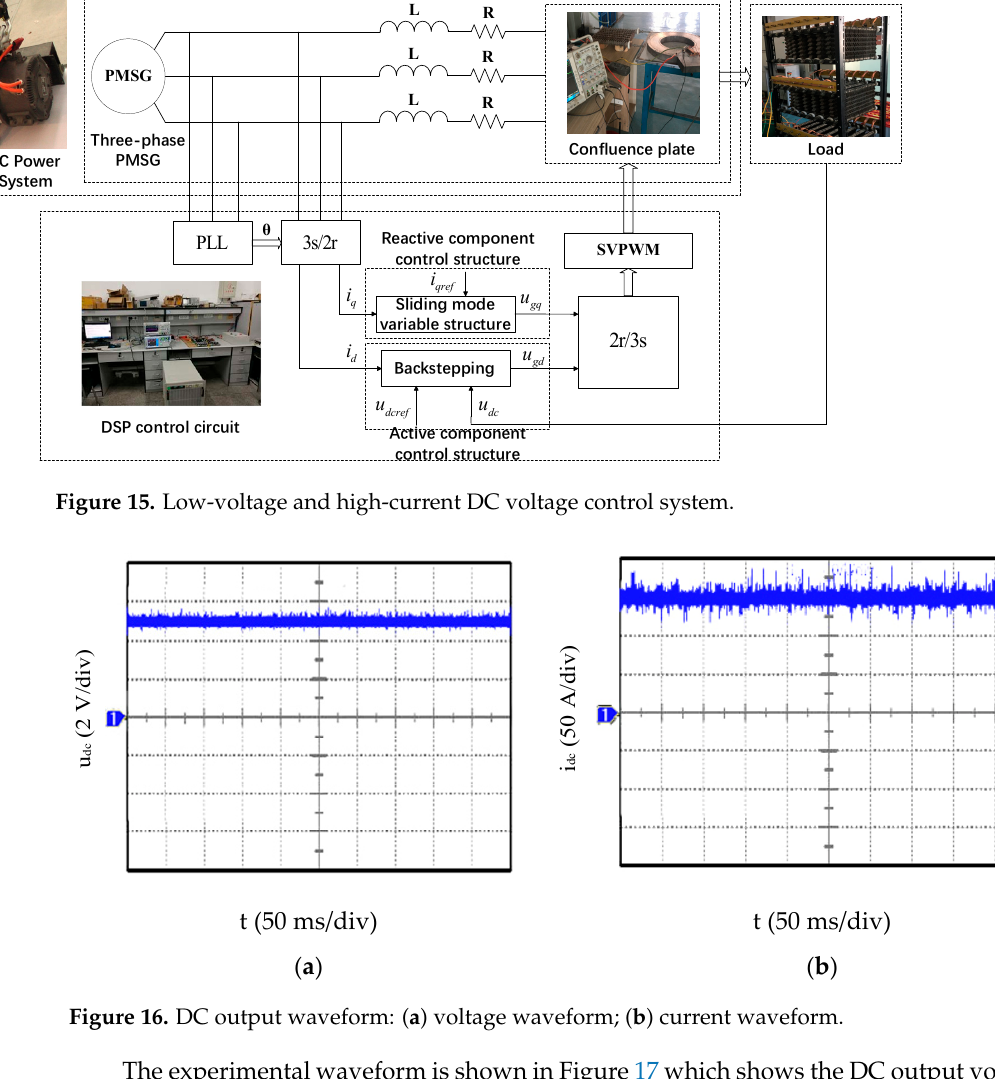
Figure 16. DC output waveform: ( a ) voltage waveform; ( b ) current waveform.